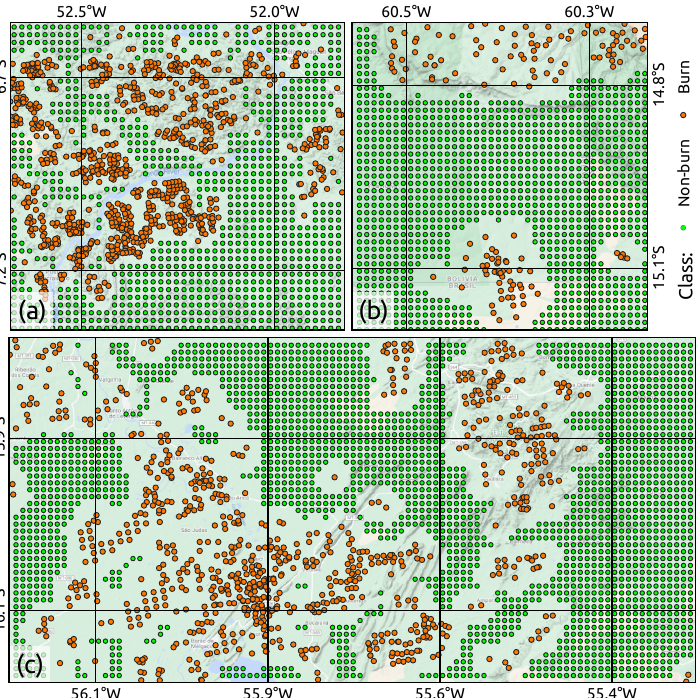
Figure 6. Ground-truth samples for ( a ) Area 1, ( b ) Area 2, and ( c ) Area 3. Point-wise burning occurrences recorded from 1 August to 31 October 2020